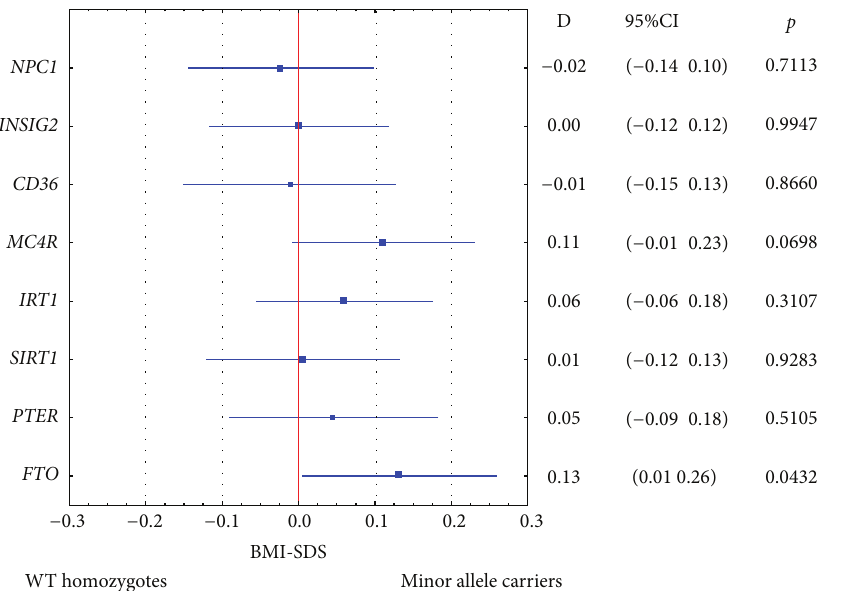
Figure 1: The influence of tested polymorphic variants on standardized BMI (BMI-SDS) in children with type 1 diabetes. D: difference of means, 95% CI: 95% confidence interval, and WT: wild-type.